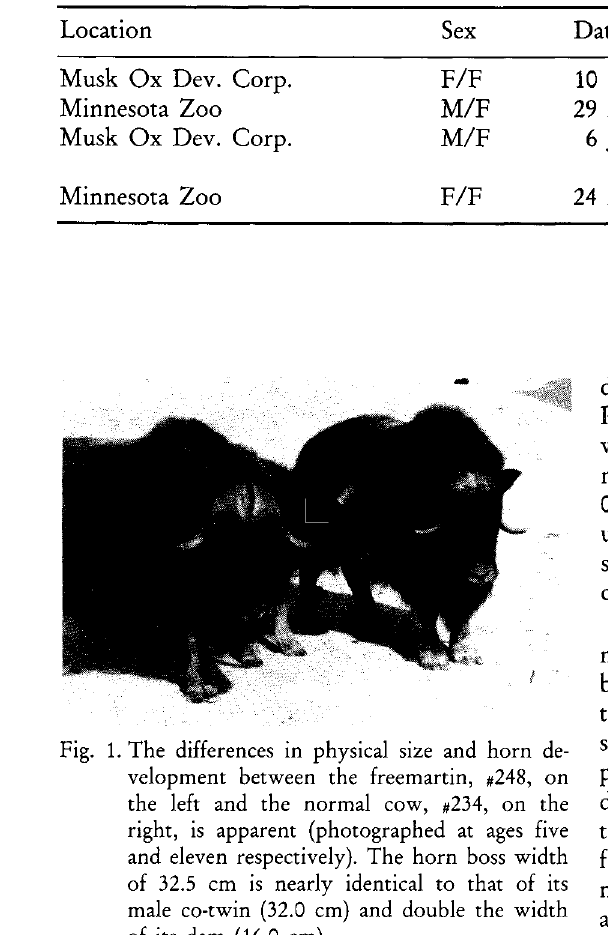
Table 1. Summary of captive born twins.